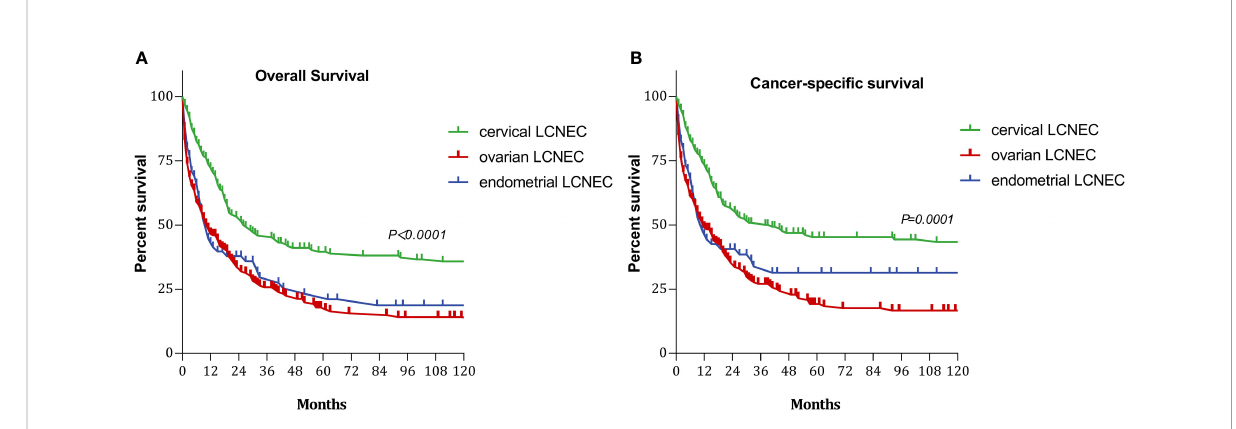
FIGURE 1 Survival curves with cervical, ovarian and endometrial LCNEC: (A) overall survival (OS); (B) cancer-speci fi ;c survival